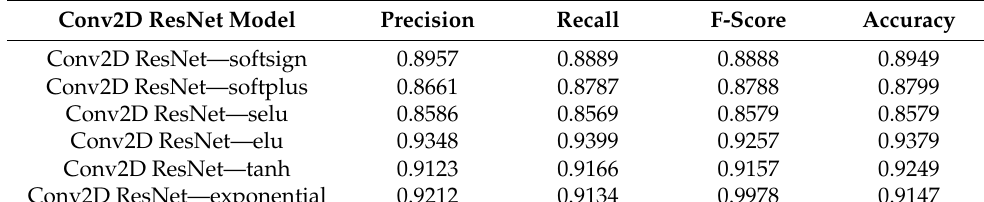
Table 8. Performance analysis for Conv2D ResNet model with various activation layers. The performance of the Conv2D Xception, DenseNet, VGG19, and ResNet models using the exponential activation layer was studied using learning curves during the train- Conv2D ResNet Model Precision Recall ing and validation phases. Figure 5 shows the accuracy and loss curves of all models over each epoch during training phase. The results revealed that accuracy gradually increased over epochs and stabilized after a threshold. The learning loss of the Xception, DenseNet, and ResNet models was more significant during early epochs and dropped as the epoch increased. Figures 6 and 7 showcase the learning curves of the models during the valida- tion phase. It is noted the performance of ResNet exponential model had a consistent in- crease in accuracy and decrease in loss at each epoch. The other models were found to have declining accuracy at certain epochs.